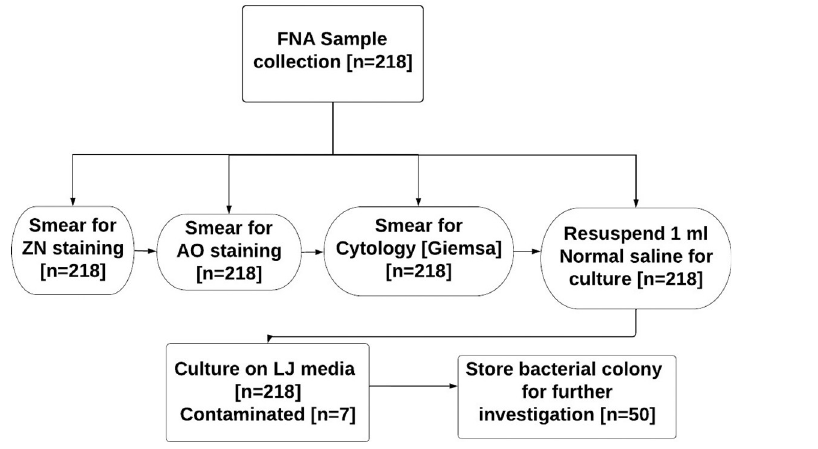
Fig 1. Flow chart of the study